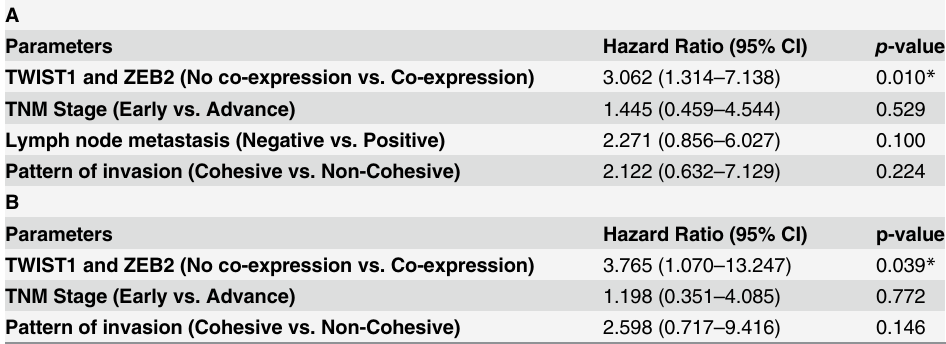
negative cervical node demonstrates that co-expression of TWIST1 and ZEB2 is an independent prognostic factor for poor overall